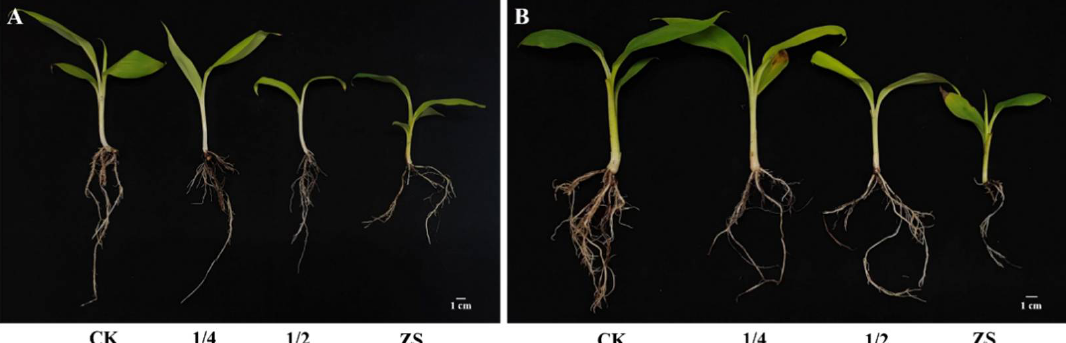
Figure 7. Effect of bamboo fungus on the growth and root development of ‘Zhongjiao No.3’ ( A ) and ‘Zhongjiao No.4’ ( B ). CK: seedlings grown in nutrient soil; 1/4: seedlings grown in nutrient soil containing 1/4 bamboo fungus culture substrates; 1/2: seedlings grown in nutrient soil containing 1/2 bamboo fungus culture substrates; ZS: seedlings grown in bamboo fungus culture substrates.